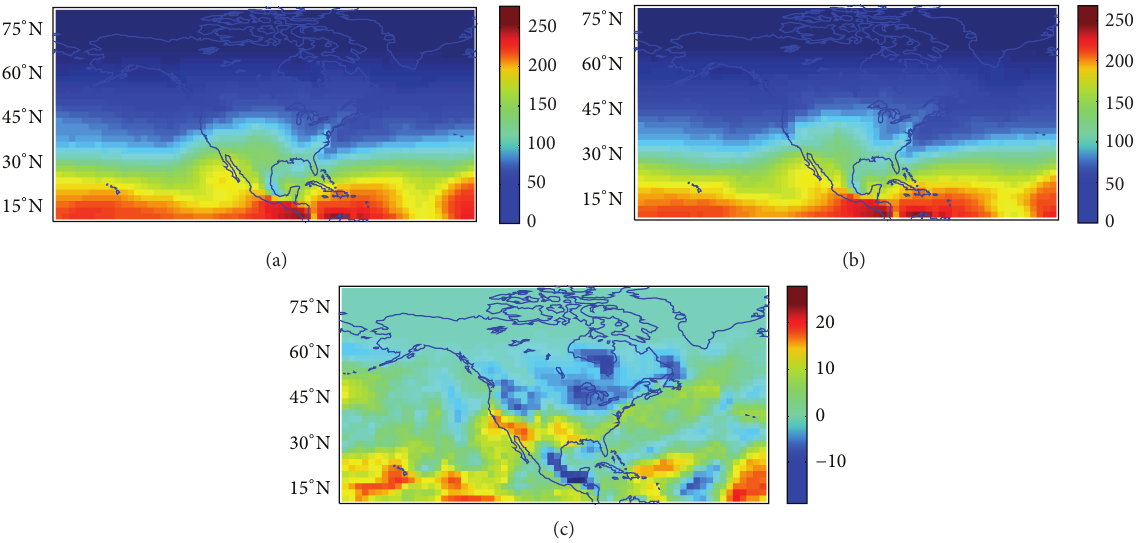
Figure 3: (a) The January climatology of downward shortwave radiation at the surface from the 21st century run with GFDL CM2.0, based on 2080–2100 average. (b) The same as (a) but from the 20th century run, based on 1980–2000 average. (c) The trend, defined as (a) minus (b). The color scales with units in W/m 2 are shown on the right.